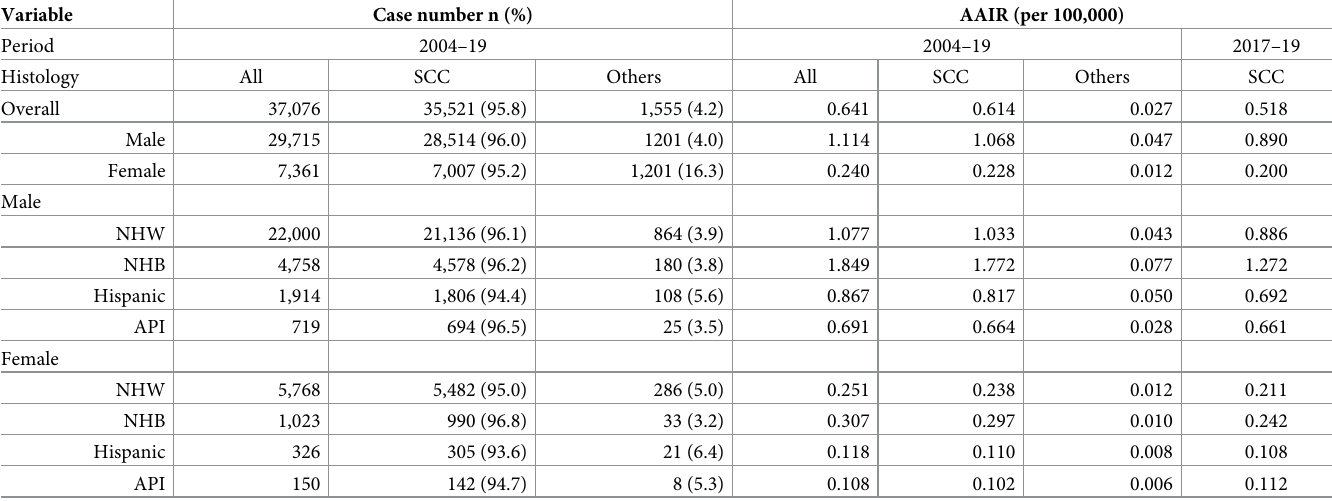
Table 1. Accumulated case number and age adjusted incidence rate (AAIR) of hypopharyngeal squamous carcinoma (HPSCC) during 2004–2019. Variable